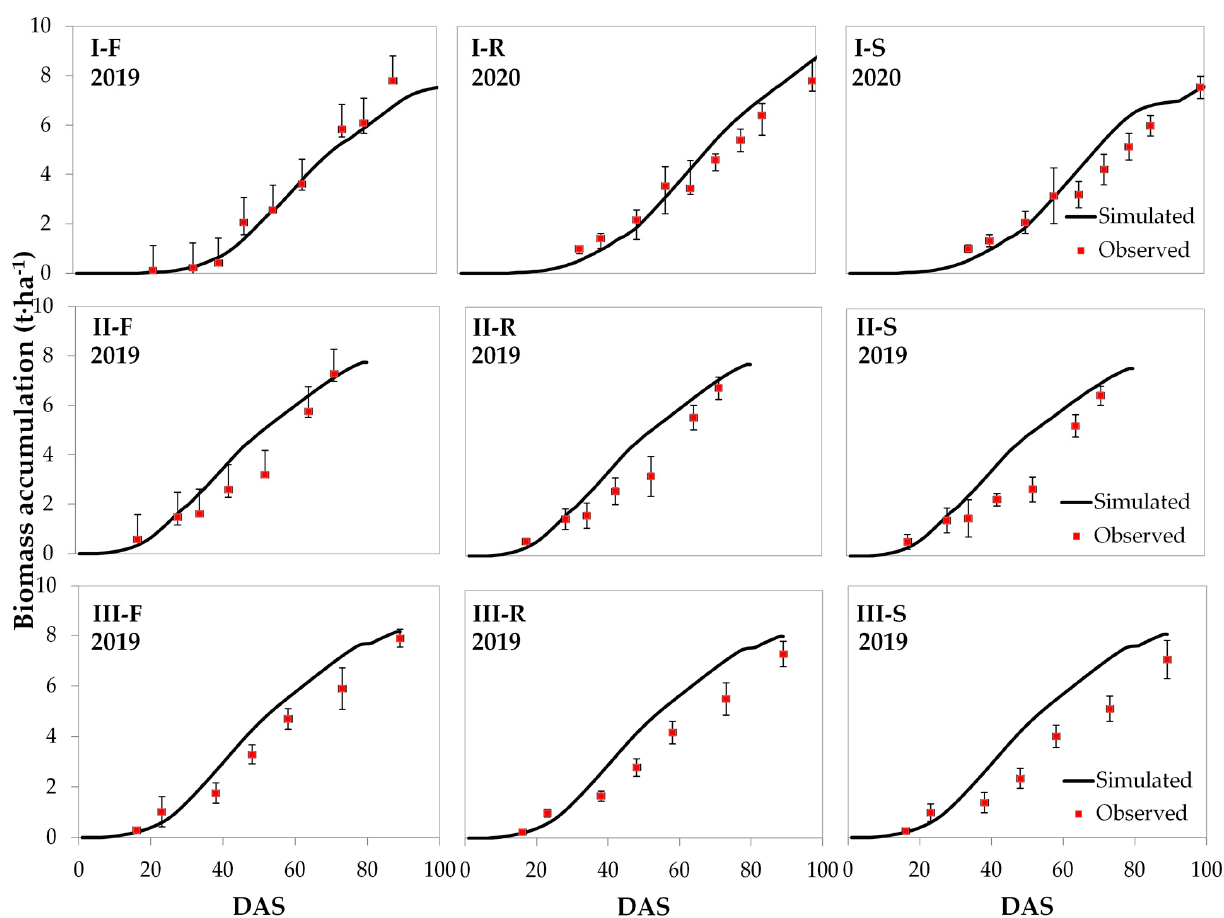
Figure 3. Simulated and observed data of biomass accumulation during the growing period of the treatments used for model validation; full (F) and de fi cit (R and S) irrigation treatments and sowing periods I (spring), II (late spring), and III (summer).